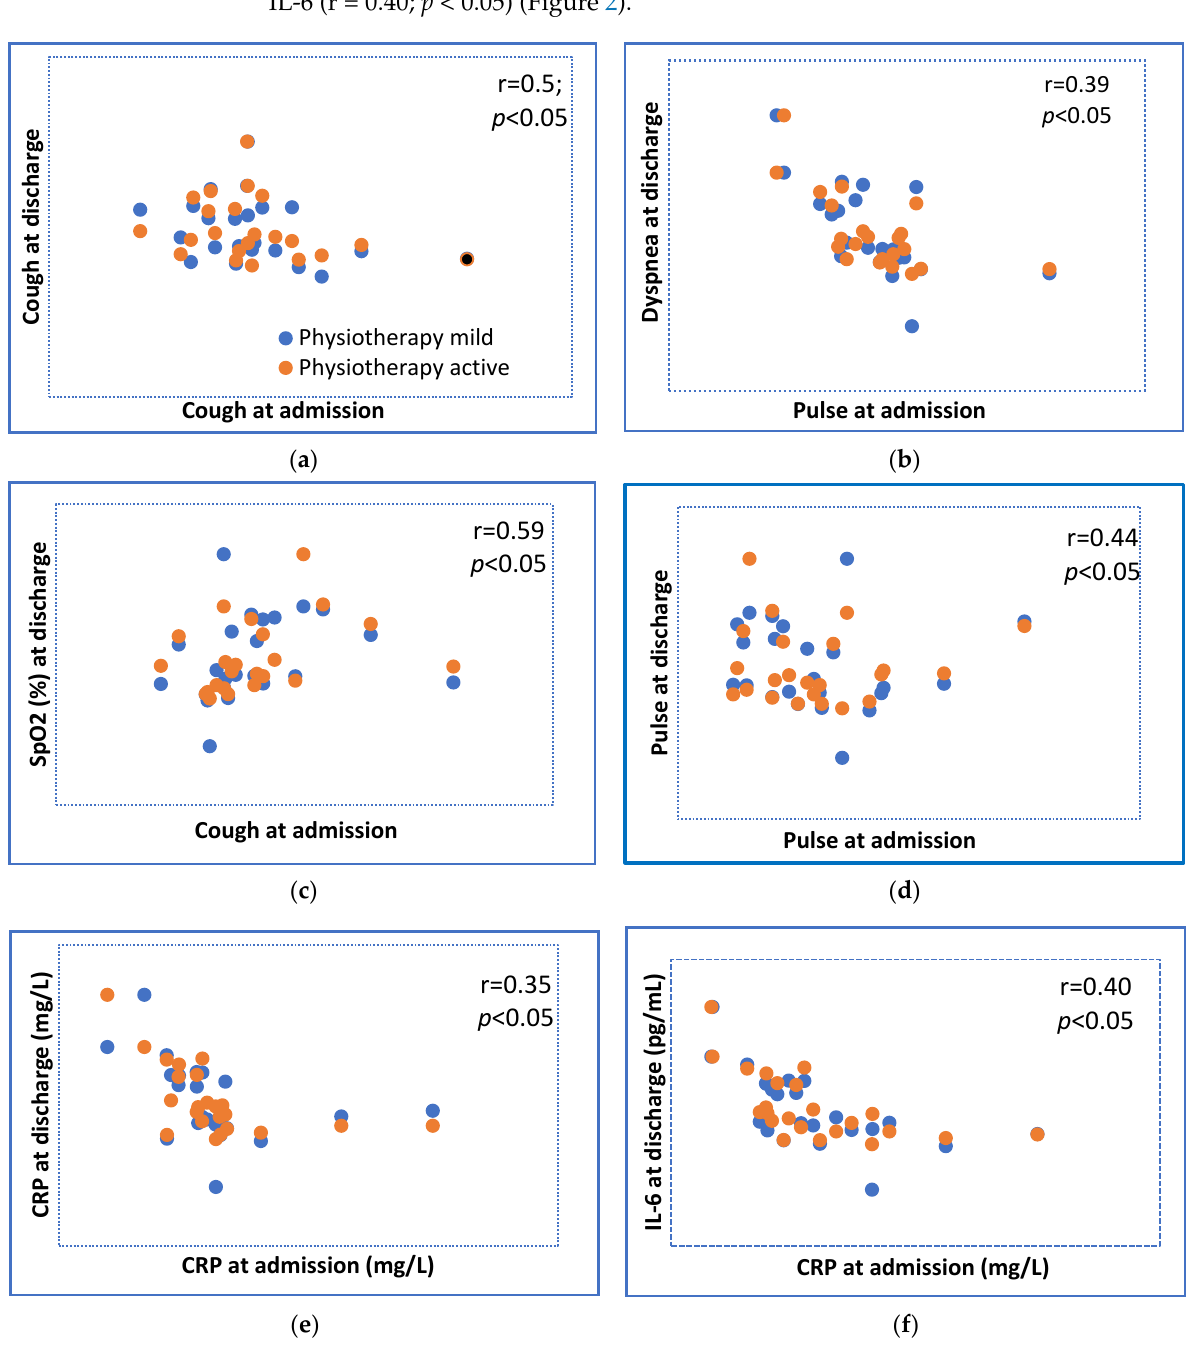
Figure 2. Spearman correlations plot between biological parameters in patients with SARS-CoV-2 infection who participated in mild physiotherapy versus active physiotherapy.